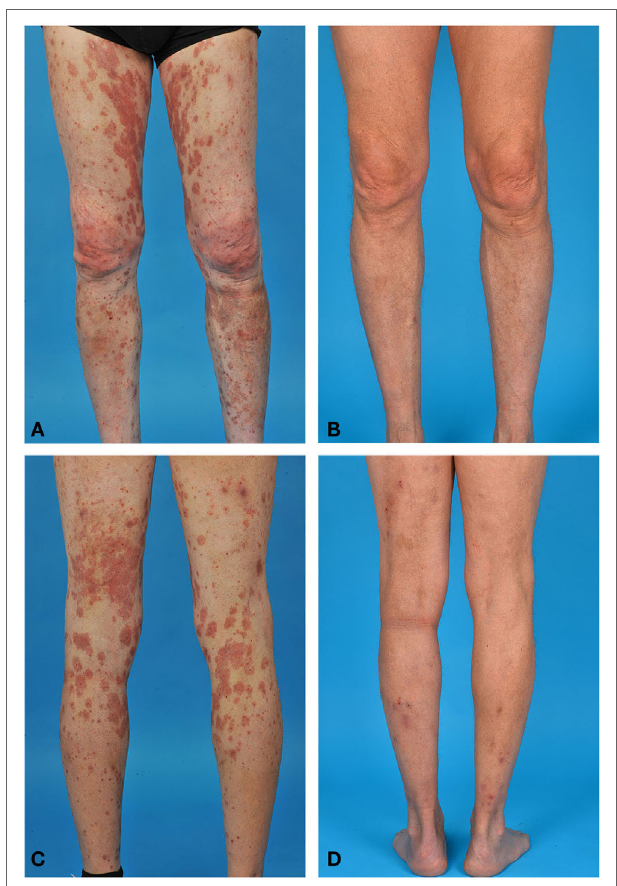
FigUre 1 | Bullous pemphigoid in a 69-year-old male. (a,c) Erythematous plaques and papules on both legs before rituximab (RTX) treatment. (b,D) Remission with minimal therapy after RTX